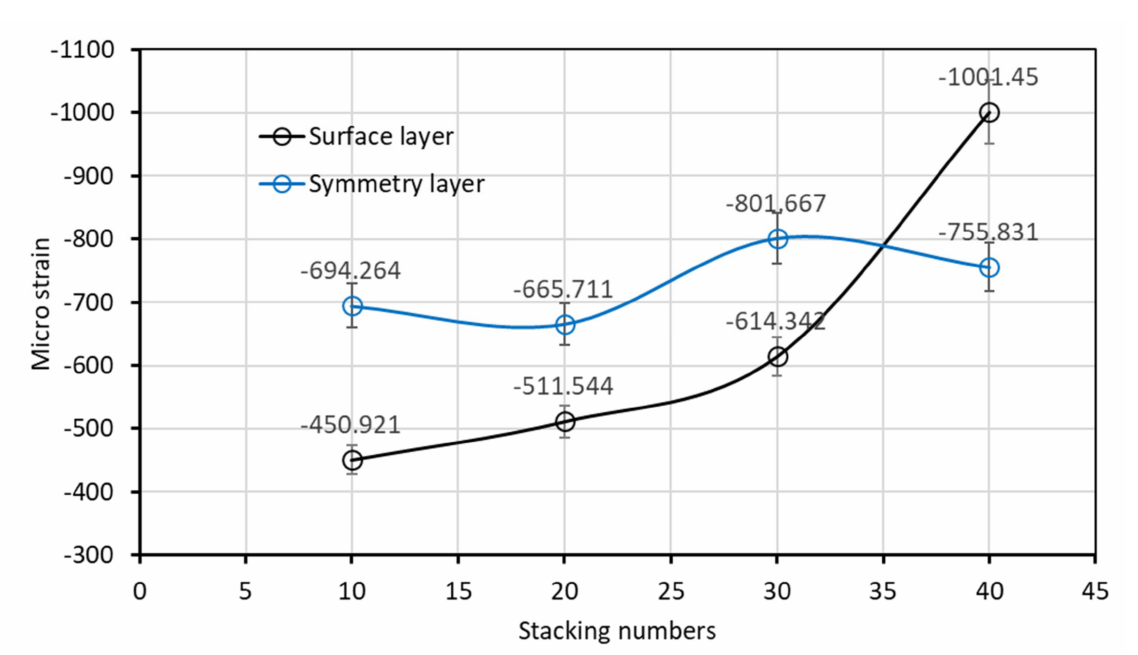
Figure 16. Residual strain measurement of the bottom layer and symmetry layer of the lami- nated